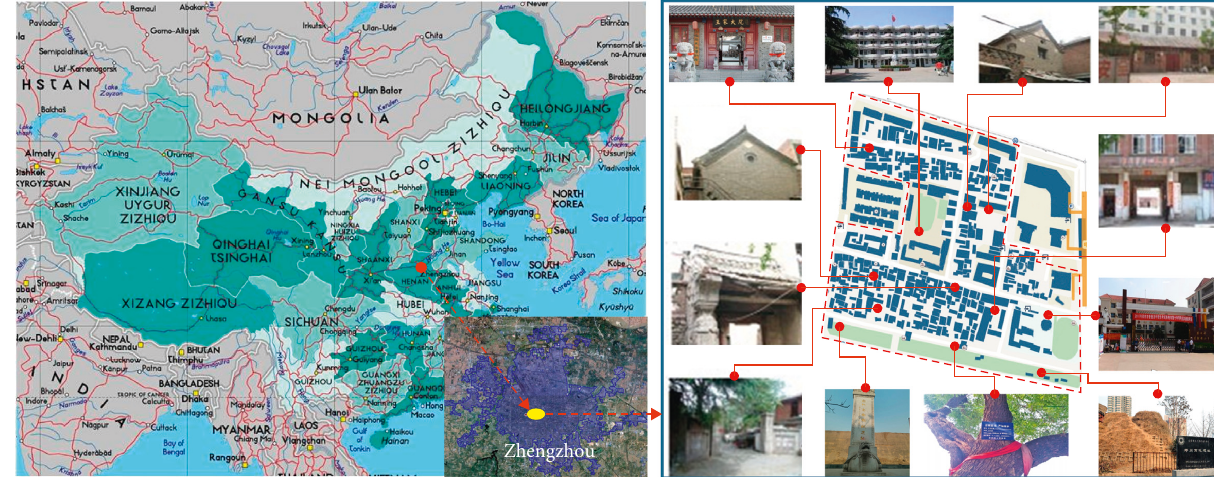
Figure 2: Distribution of the traditional elements in Academy Street.